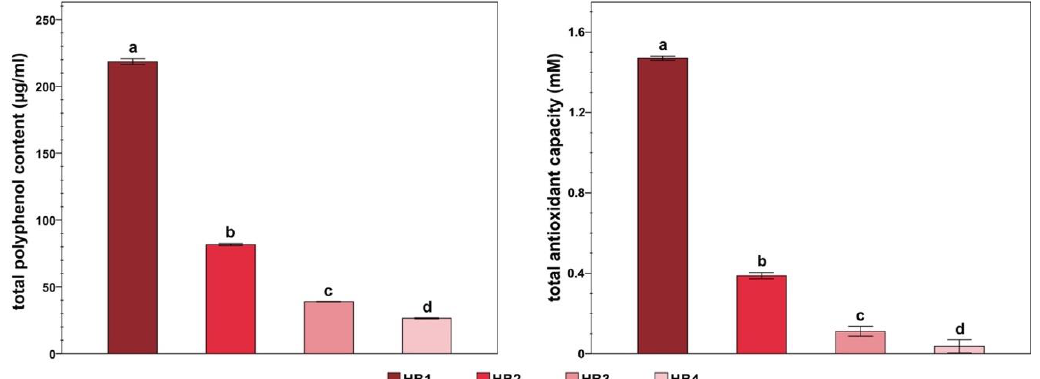
Figure 1. Total polyphenol content and total antioxidant capacity of the honeybush aqueous extracts. Different letters indicate significant differences between treatments ( p < 0.01). The total polyphenol content is expressed as gallic acid equivalents. The total antioxidant capacity is expressed as Trolox equivalents. HB = honeybush. Treatments = HB1 (20 mg/mL); HB2 (5 mg/mL); HB3 (1.25 mg/mL); HB4 (0.3125 mg/mL). The data are shown as the mean ± standard deviation of four replicates.